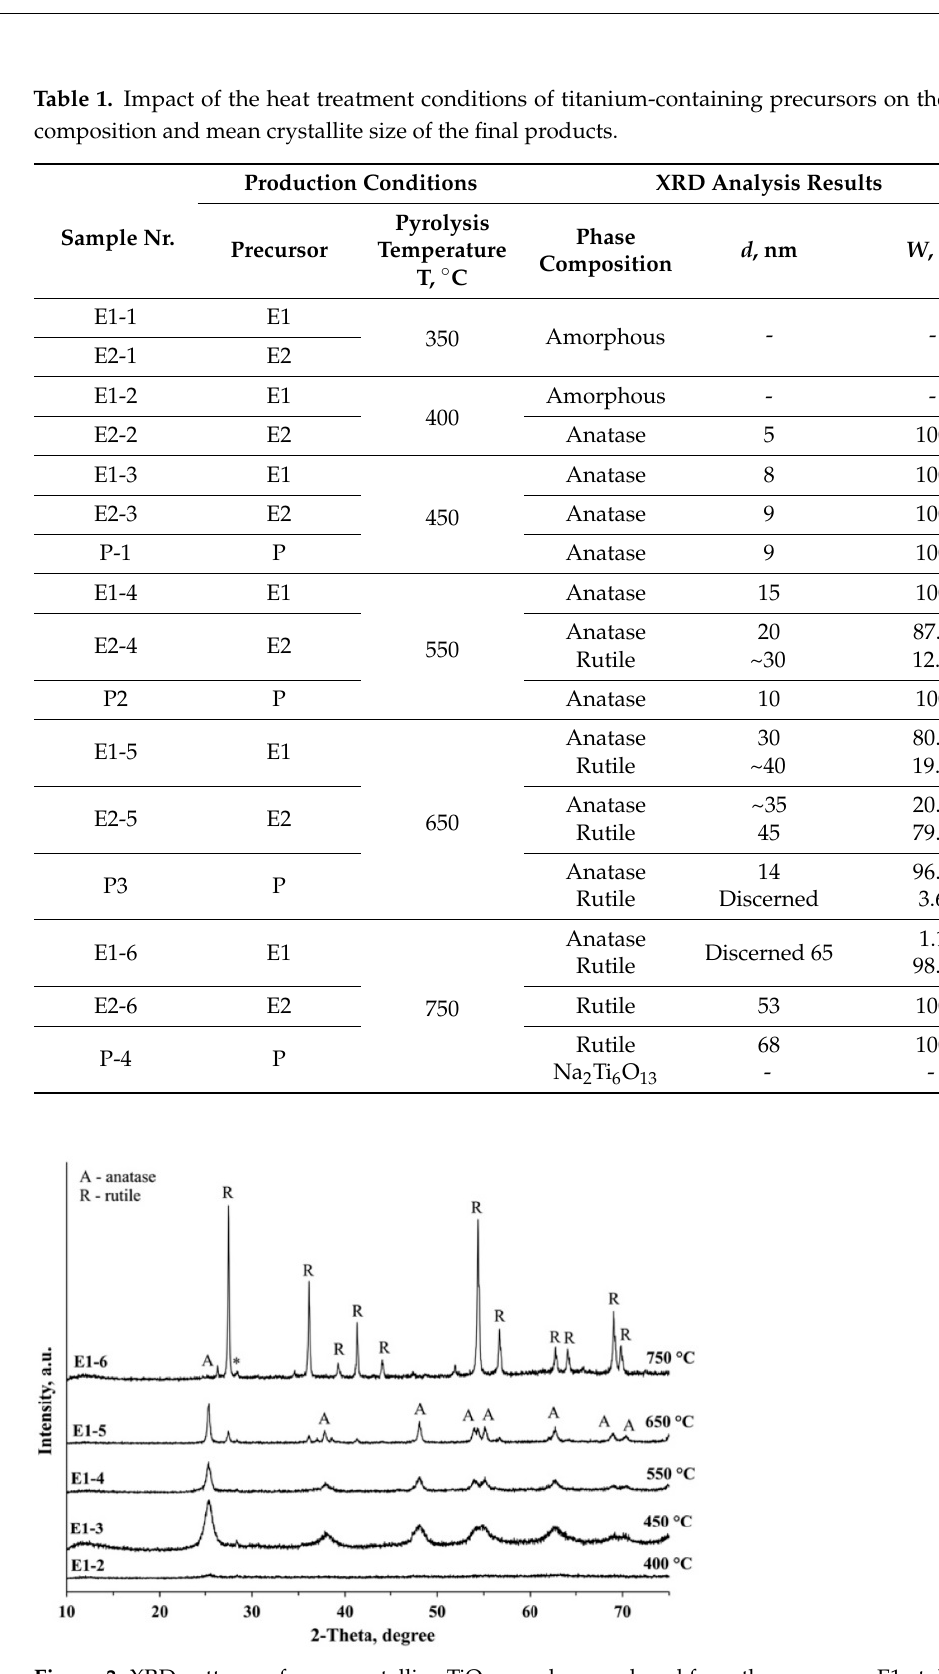
Figure 3. XRD patterns of nanocrystalline TiO 2 powders produced from the precursor E1 at different pyrolysis temperatures. * Signal of a silicon substrate from the measuring cuvette.